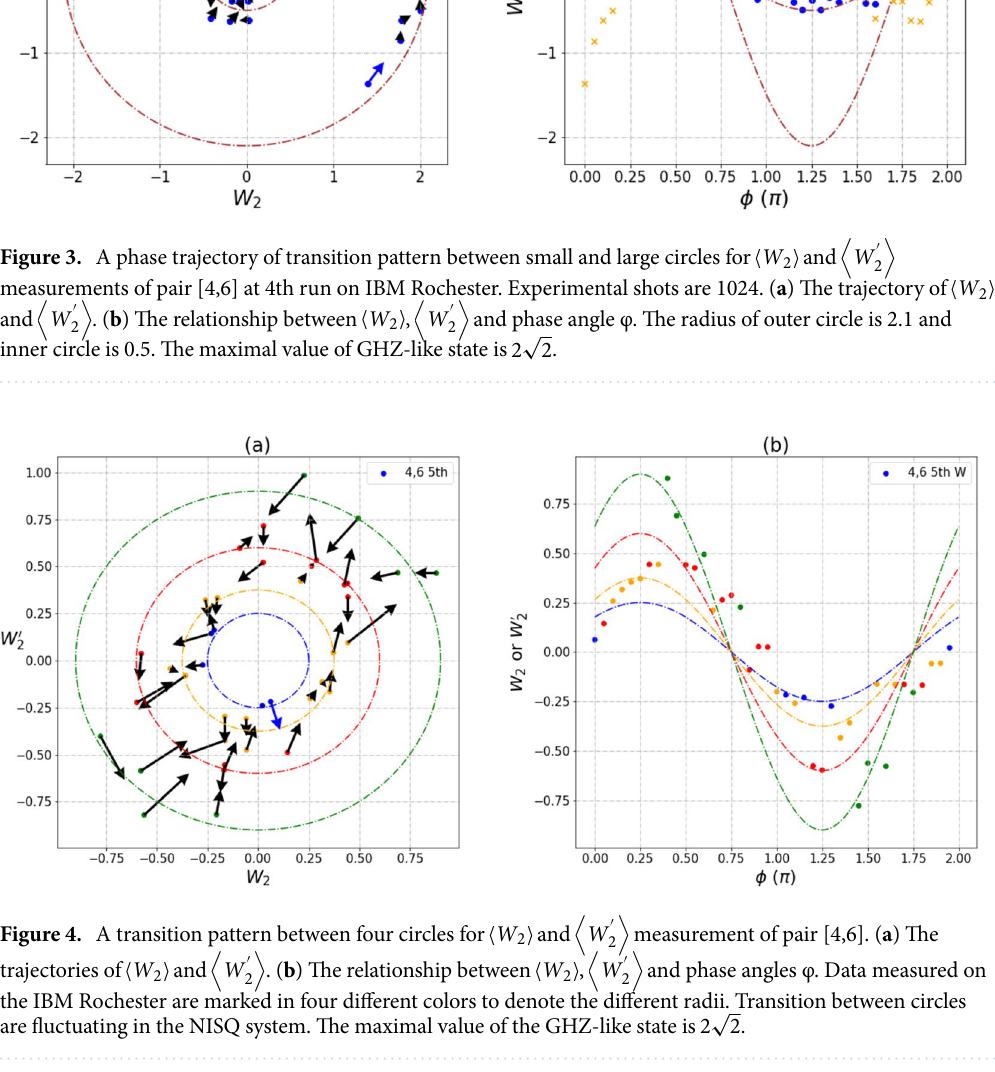
W ′ W 2 and . ( b ) The relationship between 2 (cid:30) (cid:31) (cid:31) (cid:30)